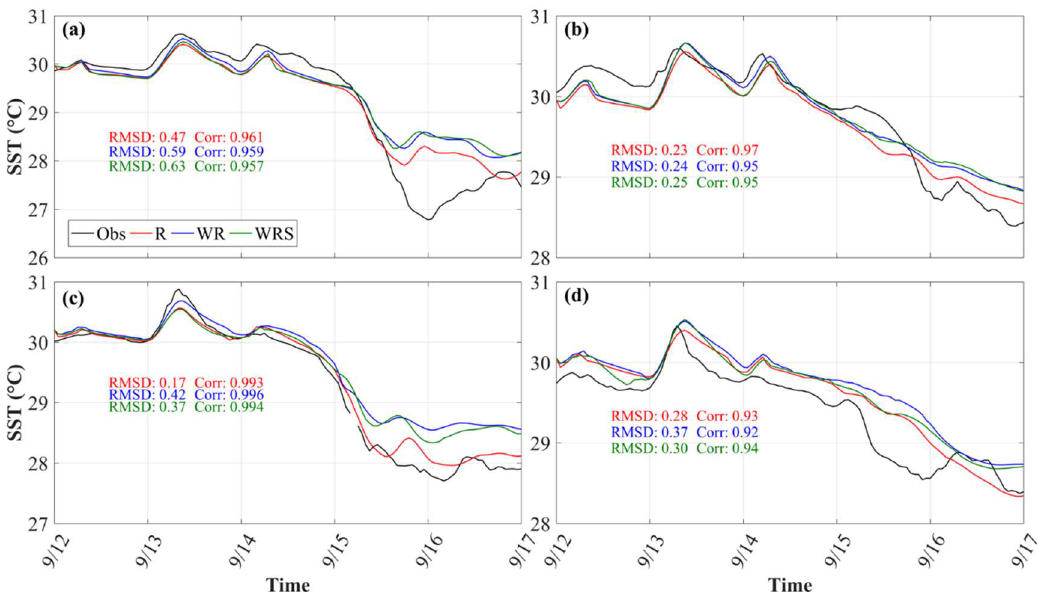
Figure 13. Spatial distribution of sea surface temperature differences (°C; background color). Difference between 16 September and 12 September for ( a ) satellite MW-IR observations; and ( b ) WRS coupled experiment. ( c ) WR minus WRS and ( d ) R minus WRS. The black line shows the TC track; the red dots are the TC positions between 12 to 17 September, with 1-day intervals, and the yellow triangles are the positions of the buoys.